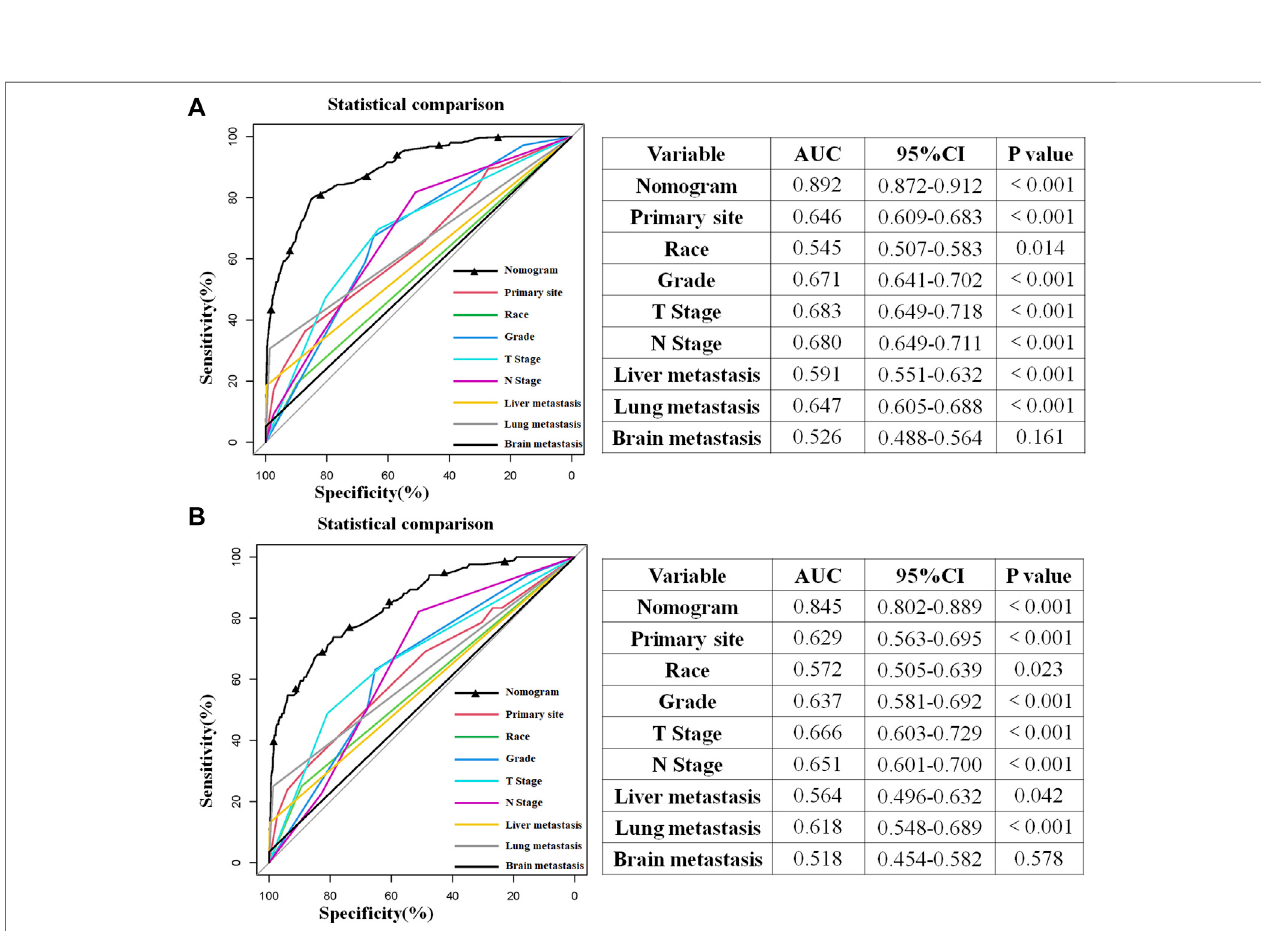
FIGURE 4 | Comparison of the area under the receiver operating characteristic curve between the constructed nomogram and the independent predictors in the training (A) andtestsets (B) .Moreover,theAUC ’ sresultsbuiltbySPSSsoftwareshowthatthecombinedmodelhadthehighestAUCinthetraining (A) andtestsets (B) , which showed that the constructed nomogram had excellent predictive ability in predicting the probability of bone metastasis in patients with head and neck cancer.